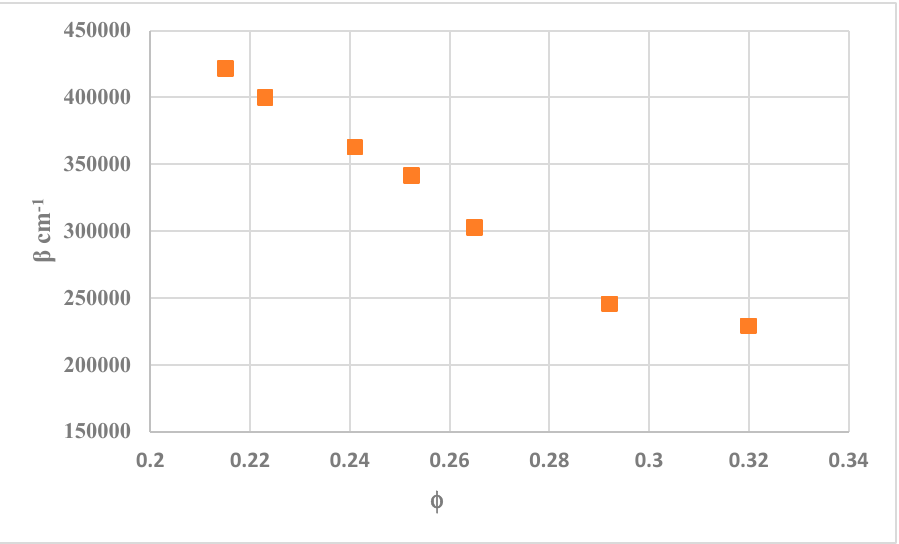
Figure 9. Non-Darcy coefficient vs. porosity.